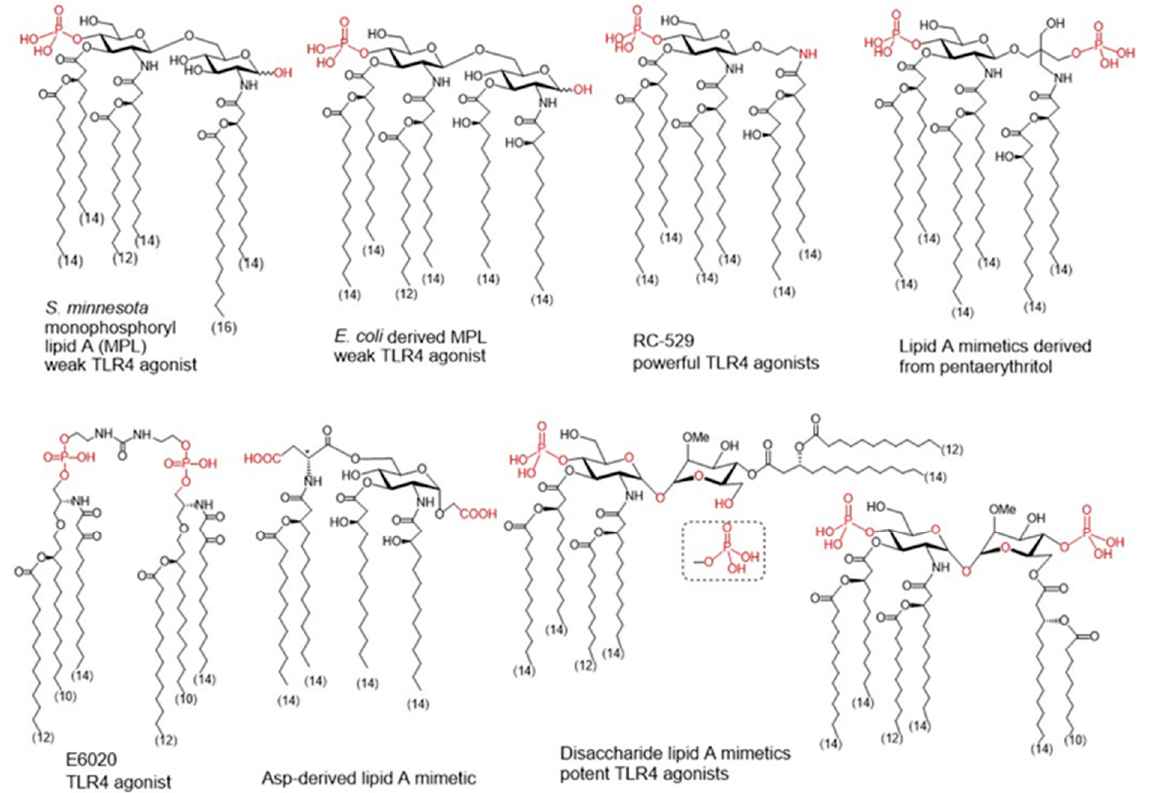
Figure 3. Monophpsphoryl lipids (MPLs)Ls and synthetic lipid A mimetics as promising vaccine adjuvant candidates.